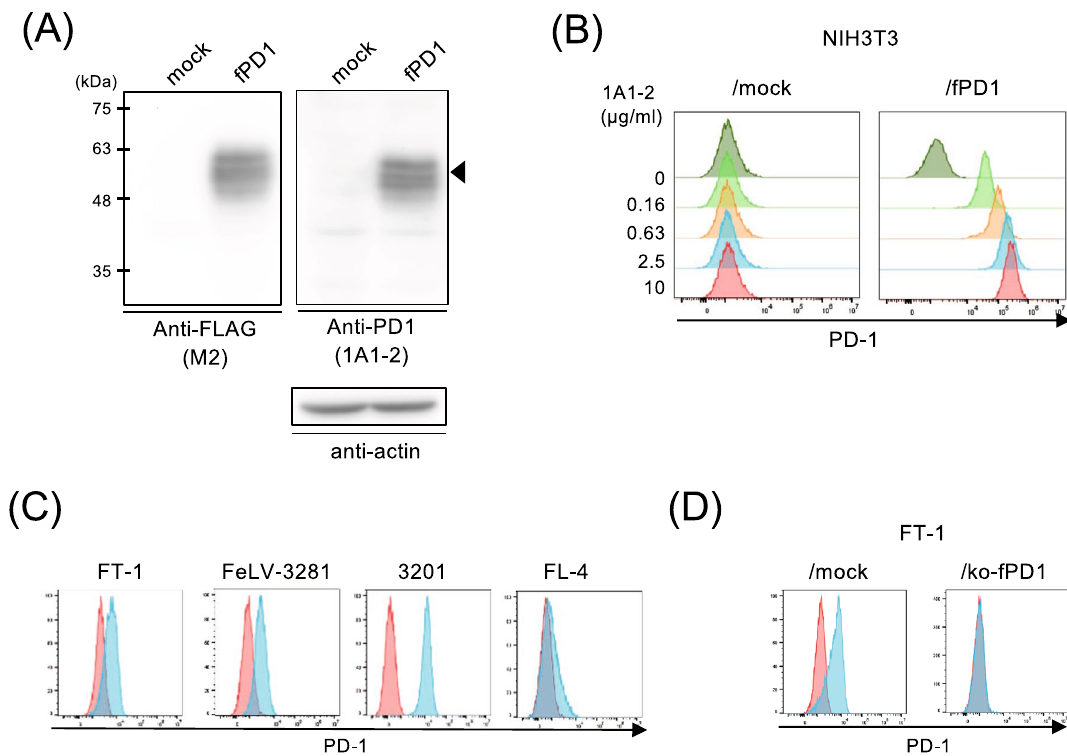
Figure 1. Specificity of anti-PD-1 mAb against feline PD-1 and analysis of PD-1 expression in feline cell lines. ( A ) Cell lysates from NIH3T3 (mock) and NIH3T3/fPD1 were used for western blotting. Proteins were separated by SDS-PAGE in two identical membranes, followed by western blotting using anti-FLAG antibody (M2) or anti-fPD1 mAb (1A1-2) in different membranes. Right blotting was reprobed with anti-β-actin antibody as the loading protein control. A representative result of 2 independent experiments is shown. Full images of western blotting at several different exposure time are shown in Supplementary Figure for Fig. 1A. ( B ) NIH3T3 or mock and NIH3T3/fPD1 or NIH3T3/fPD1 were stained with serially titrated anti-fPD-1 (1A1-2) mAb, followed by staining with secondary anti-mouse IgG-alexa647. ( C ) Flow cytometric analysis of feline PD-1 expression in feline cell lines. Cell lines were collected and stained with isotype control or anti-fPD-1 (1A1-2) mAb, followed by a secondary antibody. The red and blue histograms indicate the isotype control and 1A1-2 staining, respectively. ( D ) Flow cytometric analysis of feline PD-1 expression in feline PD-1-knocked out cell line, FT-1/ko-fPD1 cells. FT-1 cells, and FT-1/ko-fPD1 cells were collected and stained with the isotype control or anti-PD-1 (1A1-2) mAb, followed by a secondary antibody.